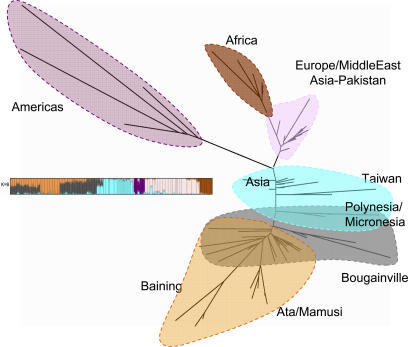
Global Population TreeNeighbor-joining F
ST-based tree for the Pacific and HGDP-CEPH combined datasets (687 microsatellites). Superimposed colors are from the STRUCTURE analysis at K = 6 (also shown).